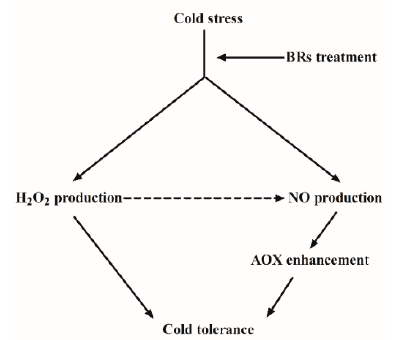
Figure 7. Model illustrating the involvement of H 2 O 2 and NO in BRs-induced cold stress tolerance.